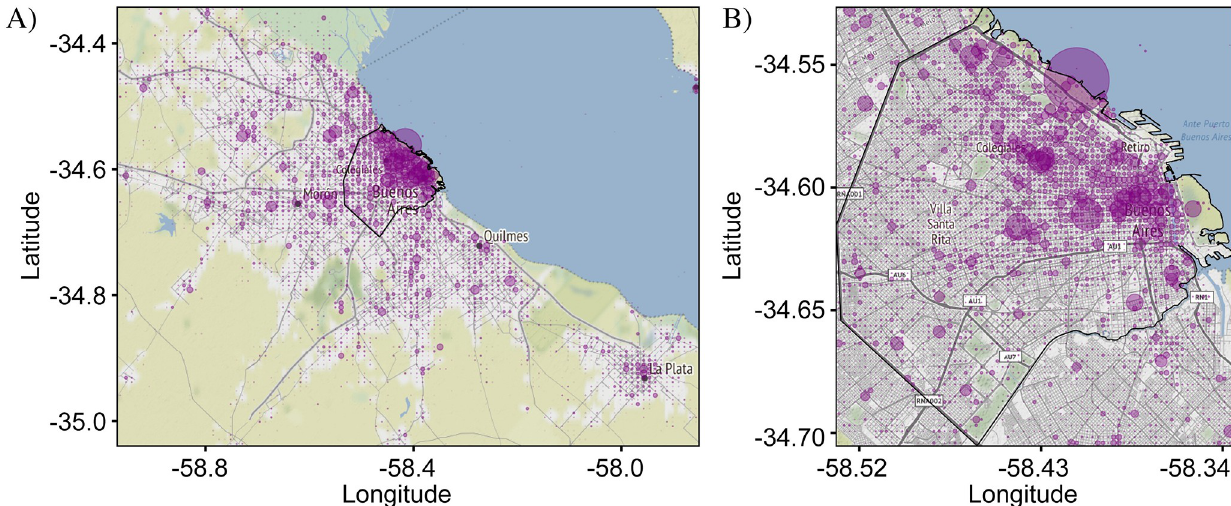
Fig 1. Geographical plot of the spatial distribution of all Spanish tweets in Buenos Aires. Each circle corresponds to an individual bin and its size represents the number of tweets in that bin. (A) Distribution in the greater metropolitan area of Buenos Aires (CABA+) which is sub-divided into 100 x 100 bins. (B) Distribution in the administrative boundary of the city of Buenos Aires (CABA)–delineated in black–which is sub-divided into 75 x 75 bins. Both distributions show greater tweet counts in the more population-dense regions corresponding to the downtown area (upper-right quadrant of (A)). The total number of tweets in the CABA+ and CABA extents were 1,930,987 and 1,065,614, respectively. Base map and data from OpenStreetMap and OpenStreetMap Foundation under the Open Database License.